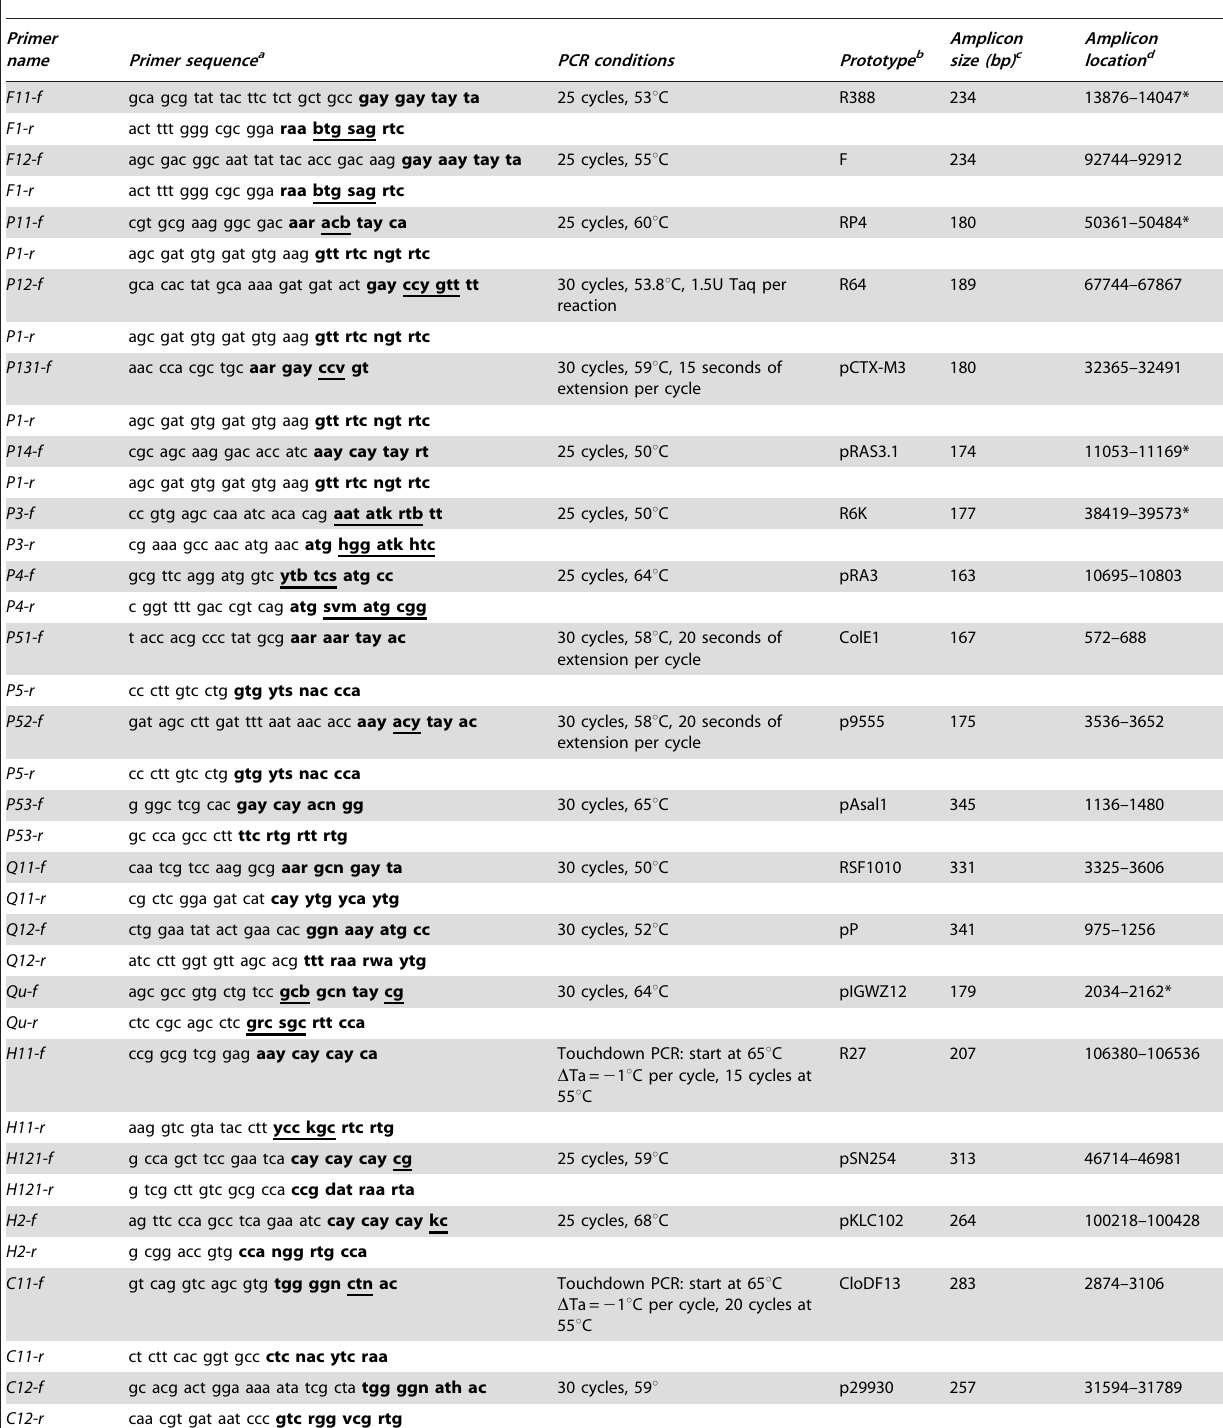
Table 2. List of degenerate primers used for